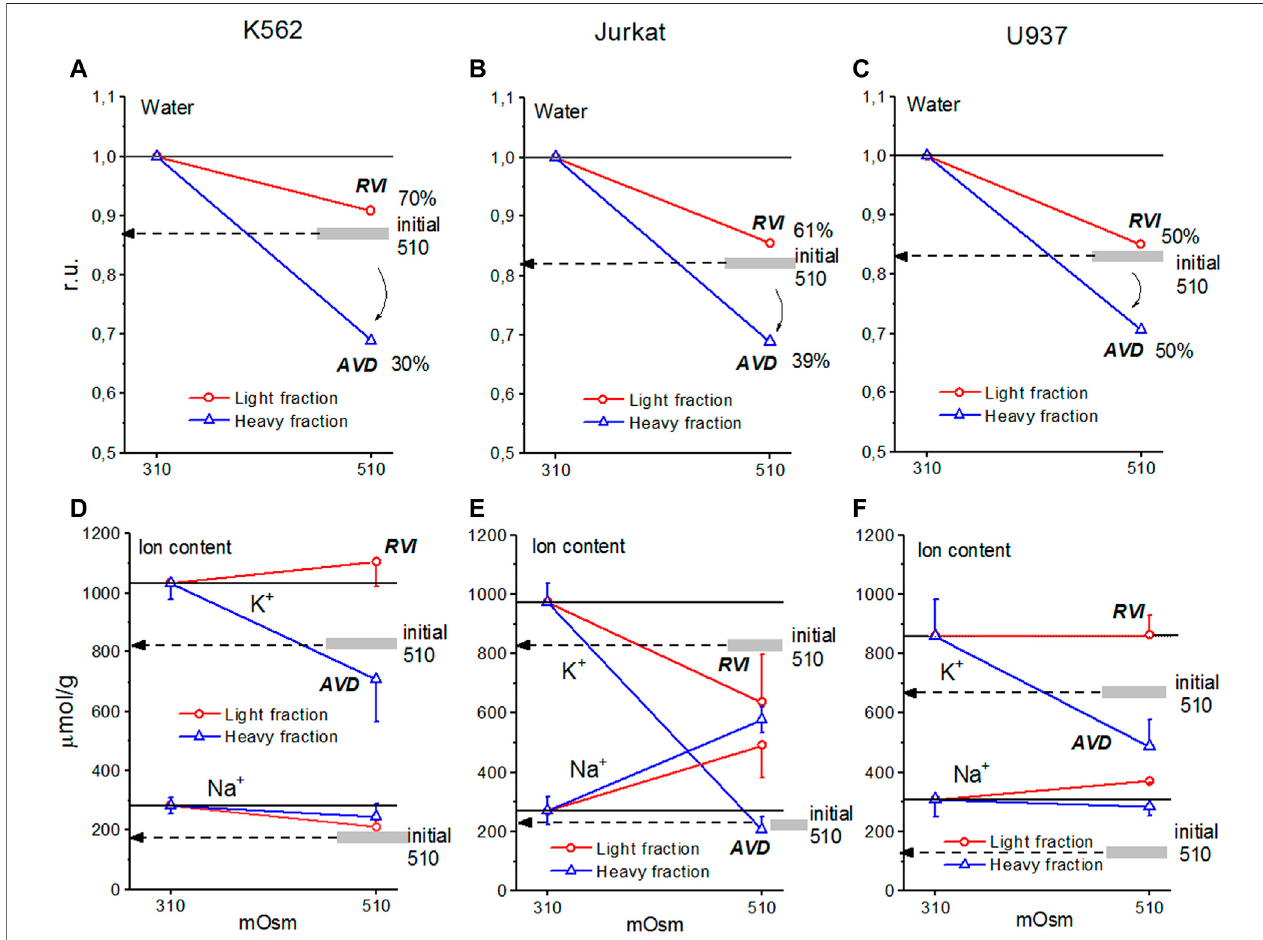
FIGURE 7 | Cell water, K + , and Na + content in living K562 (A,D) , Jurkat (B,E) , and U937 (C,F) cells before and after 4 h incubation in hyperosmolar medium with 200 mM sucrose (510 mOsm). The broad gray lines show the level of the initial water and ion content in hyperosmolar medium (15 min incubation).